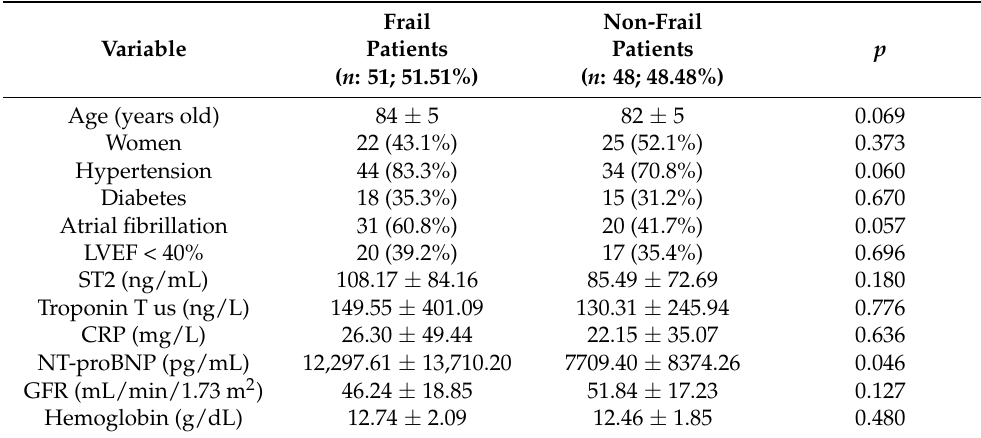
Table 2. Baseline characteristics in the group of old